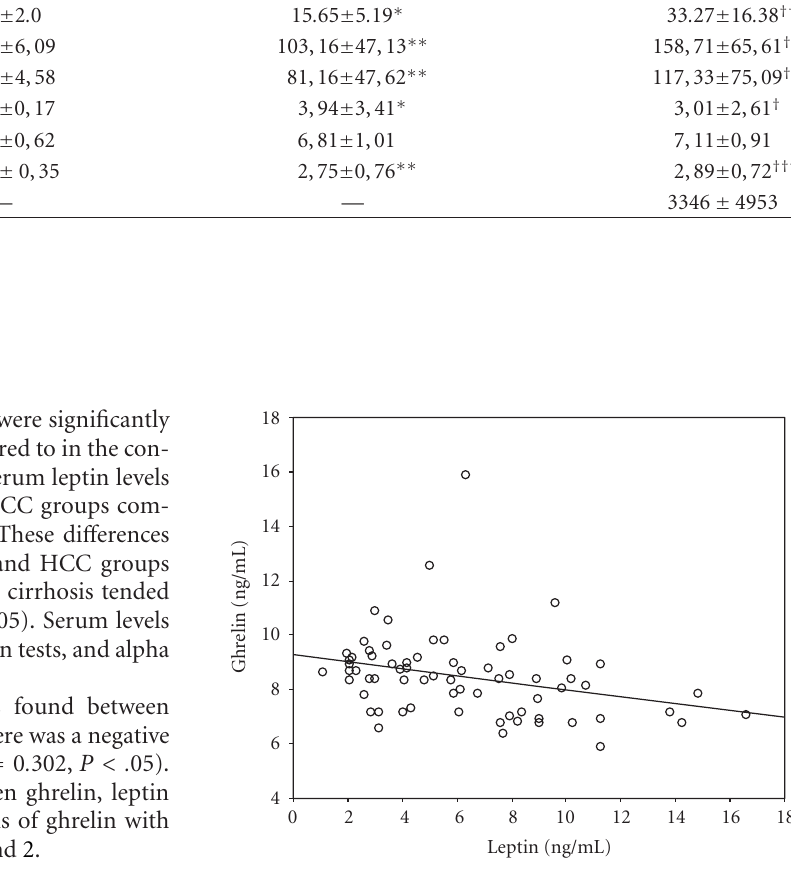
Figure 1: The relation of ghrelin and leptin. There was a negative correlation between ghrelin and leptin ( r : 0 . 302, P < .